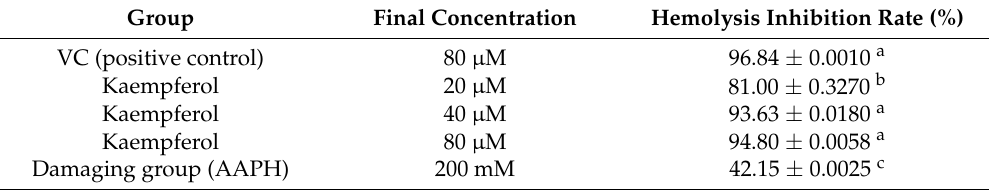
Table 1. Kaempferol suppresses AAPH-induced erythrocyte hemolysis. Group Final Concentration